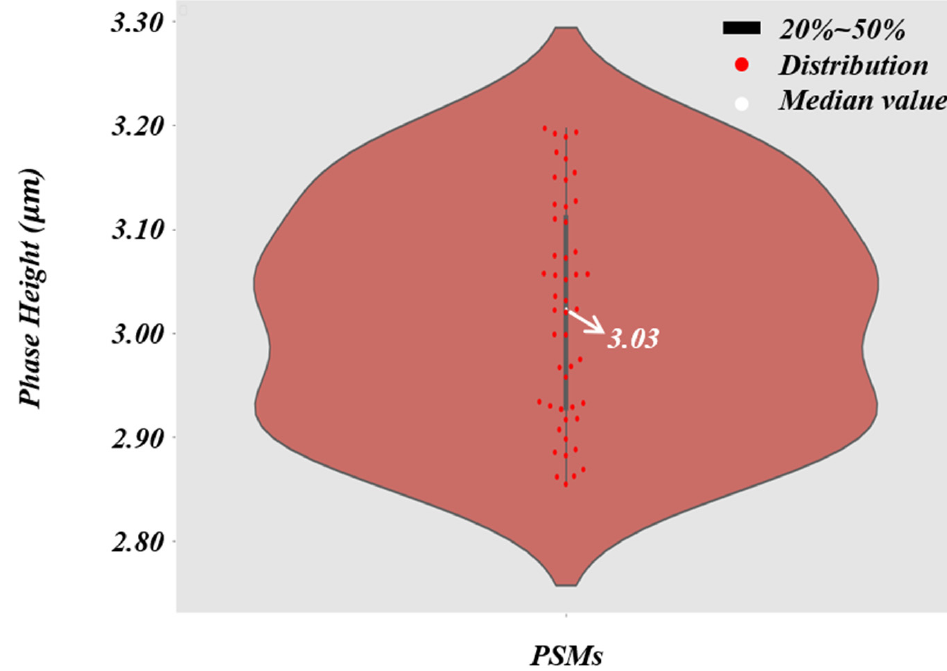
Figure 7. The violin plot of the PSMs’ phase height. The thick black line in the middle indicates the interquartile range, the thin black line extending from it represents the 95% confidence interval, the white dot is the median value, and the red spots indicate the distribution of the PSMs’ phase heights.